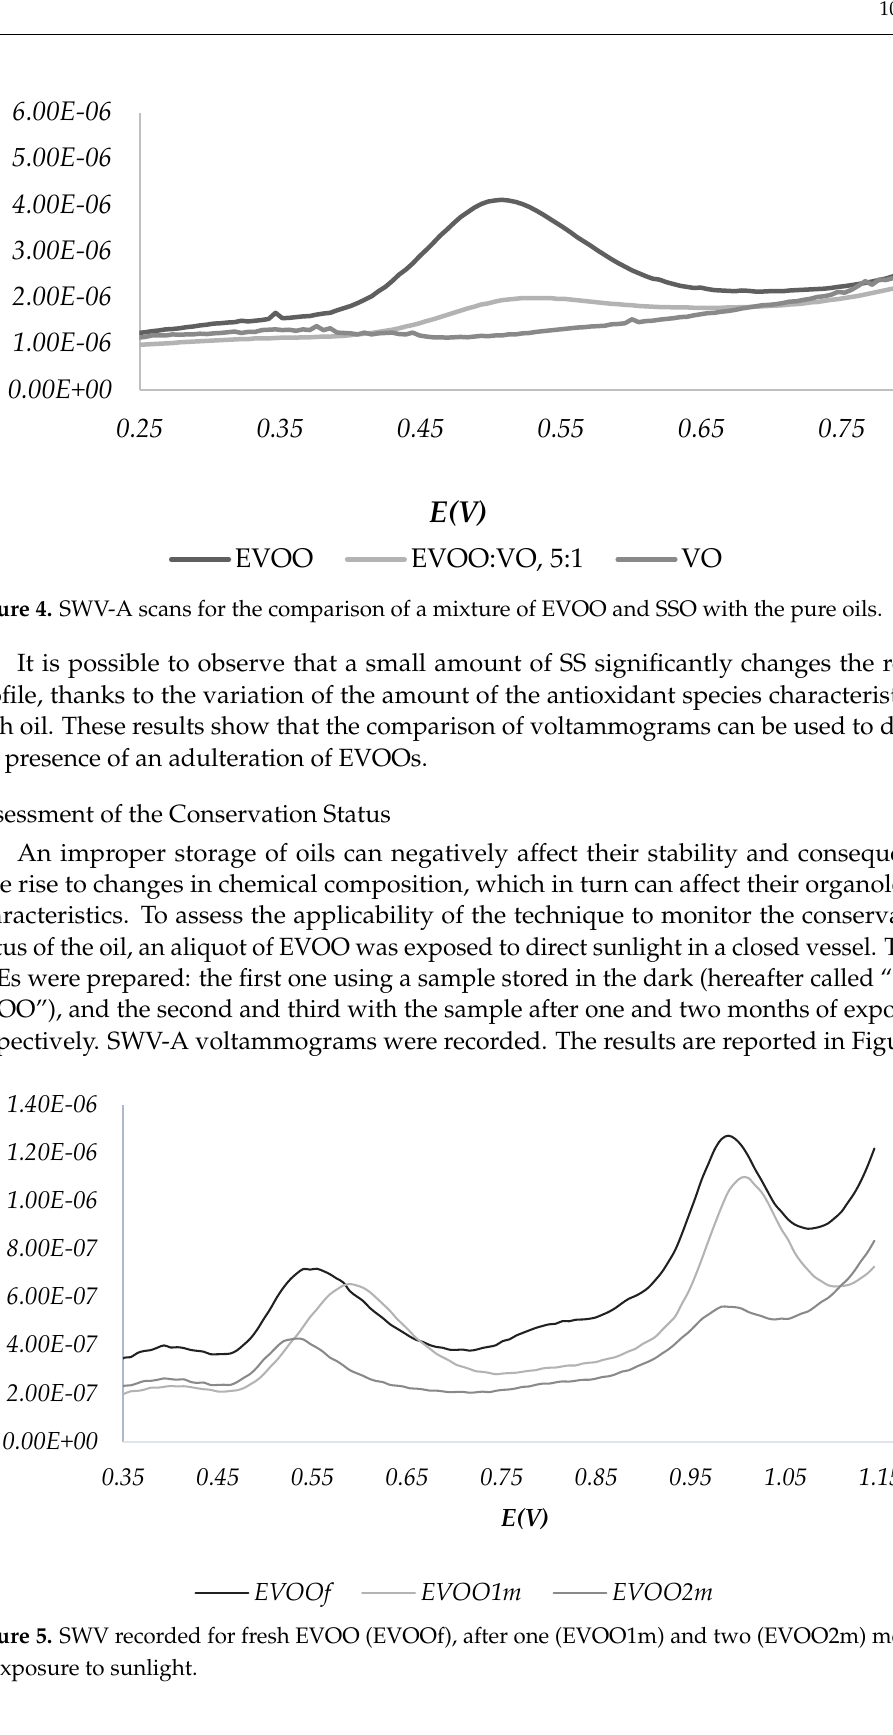
Figure 5. SWV recorded for fresh EVOO (EVOOf), after one (EVOO1m) and two (EVOO2m) months of exposure to sunlight.